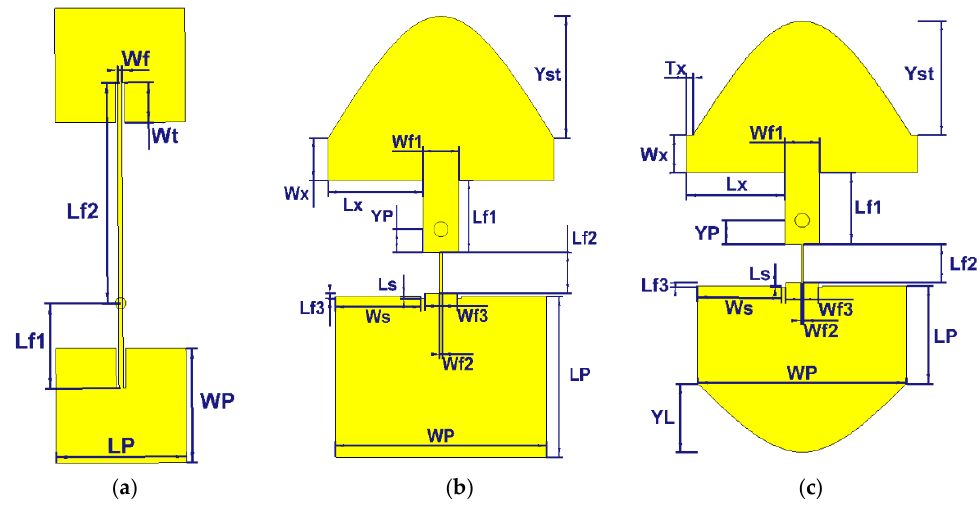
Figure 1. Topologies: ( a ) preliminary patch antenna array; ( b ) proposed patch antenna array with rectangular bottom patch; ( c ) proposed patch antenna array with two elliptical patches.